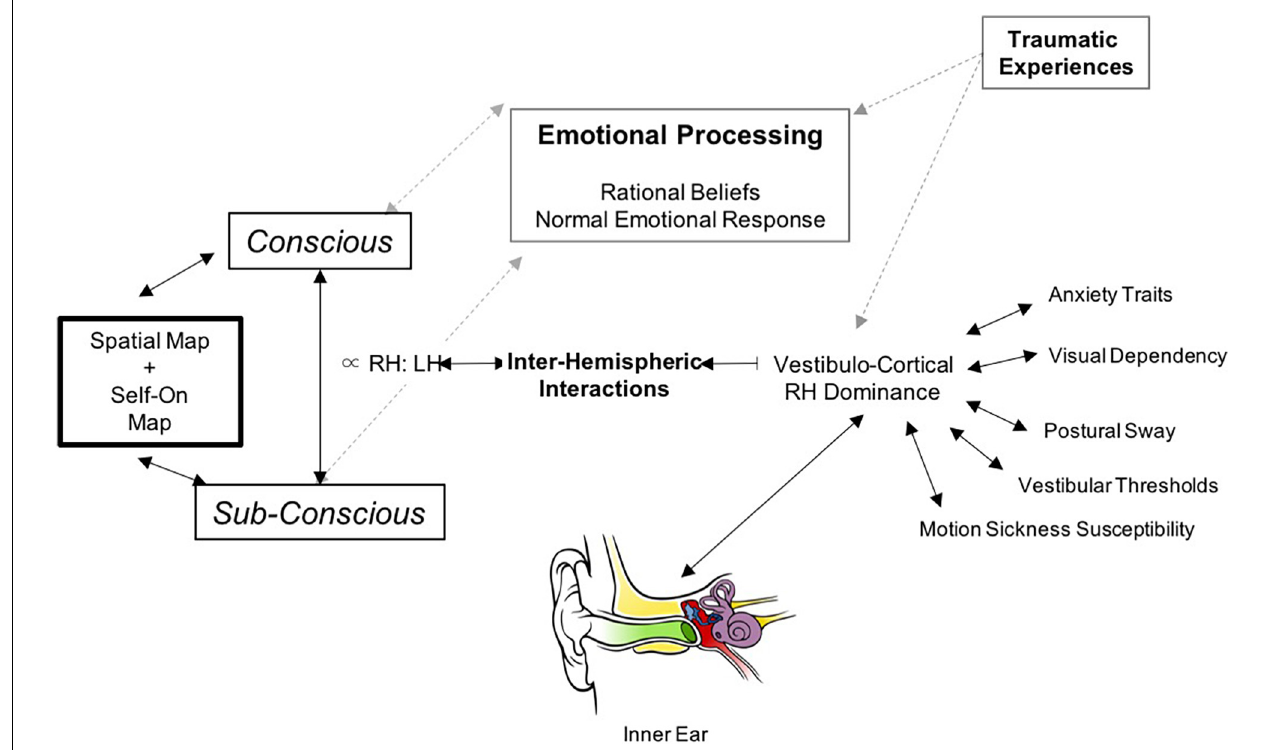
FIGURE 7 | Schematic illustration of our proposed neurobiological model for PPPD: The central component in the model is the interhemispheric interactions in the vestibulo-cortical network that determines its dominance and in-turn influences risk factors for developing PPPD including lower motion perceptual thresholds, increased sway during postural control, increased motion sickness susceptibility, higher visual dependence, and anxiety. These interhemispheric interactions can also be influenced by predisposing emotional trauma (non-vestibular). This cortical network receives signals from bottom-up vestibular transformations provided by the vestibular system. The net result of the cortical system is to generate perceptual vestibulo-spatial and vestibulo-temporal maps of the world, and this is cross-referenced with physical signals from the accelerometers (balance organ) in our inner ear. If there is a mismatch as in the case of PPPD – this subsequently opens up feed-forward pathways to emotional